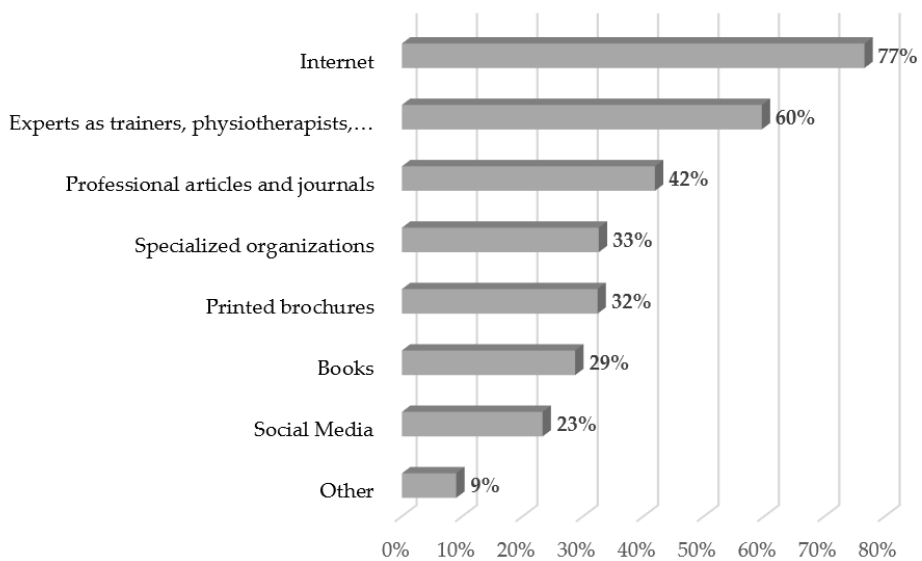
Figure 2. Sources for information about PA for people with an ID in % (multiple answers possible).